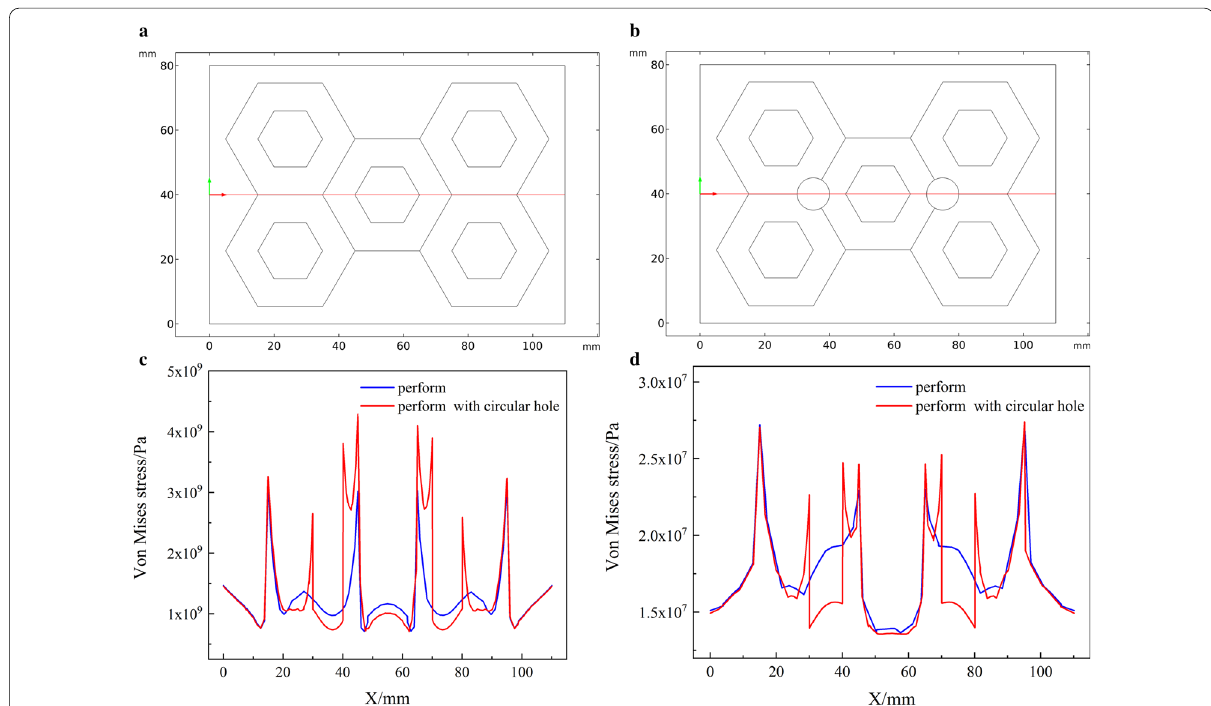
Fig. 5 The position of the 2D transversal of the simplified model and stress transversal comparison. a Initial perform, b partial enlarged view of the initial perform, c preform with circular holes added, d partial enlarged view of the perform with circular holes added